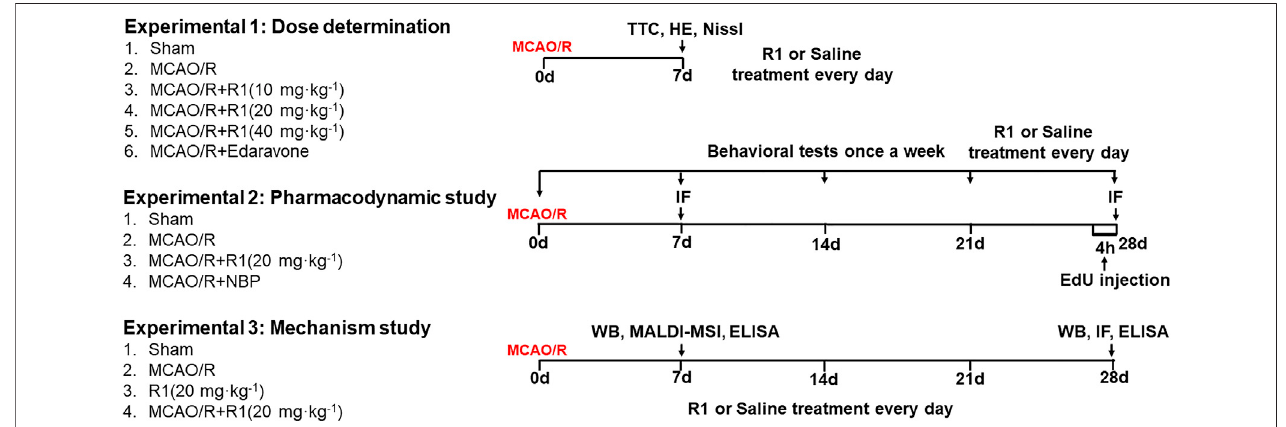
FIGURE 1 | Schematic graphic of the rat experimental design. On the left is the group information, and on the right is the timeline of the experimental